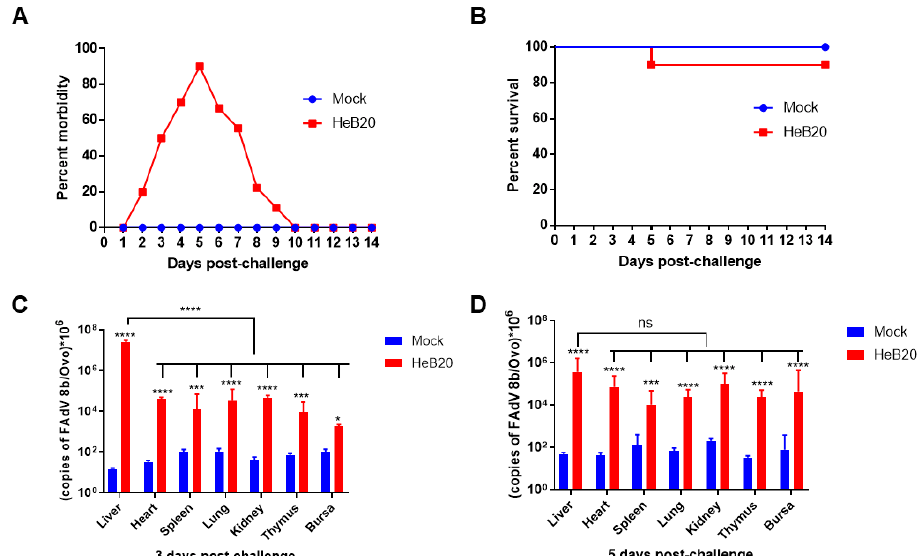
Figure 4. Pathogenicity analysis of HeB20. ( A ) Morbidity curves and ( B ) survival curves of chickens infected with HeB20. ( C ) Virus distribution in chickens at 3 dpi. Virus concentrations in the livers were significantly higher than those in the heart, spleen, kidneys, thymus, and bursa ( p < 0.01). ( D ) Virus distribution in chickens at 7 dpi. There was no significant difference in the viral load of the heart, liver, spleen, lung, kidneys, thymus, or bursa ( p > 0.05). The significance of differences was determined using two-way analysis of variance; ns, not significant, * p < 0. 05, *** p < 0.001, and **** p < 0.0001.